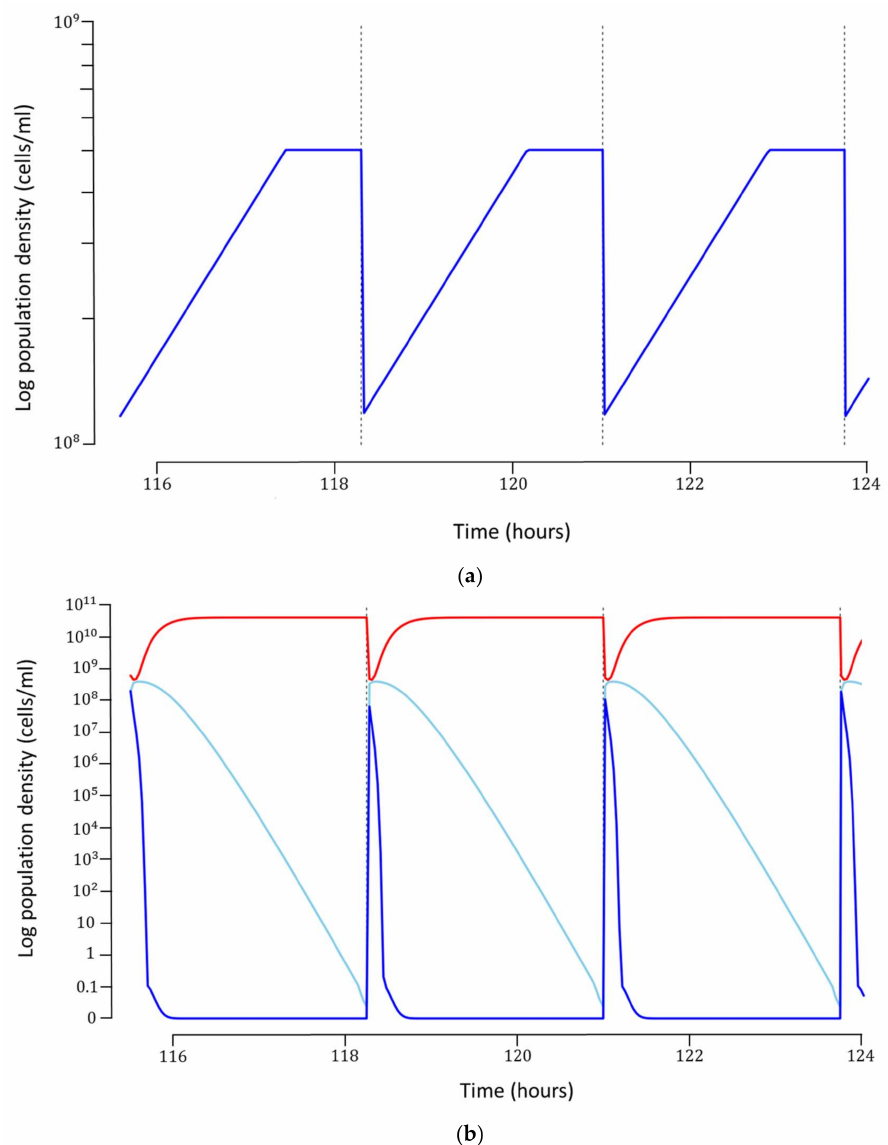
Figure 3. The concentration of bacteria and phages during simulation of the two-stage, self-cycling process for phage production. ( a ) SCF-tank where only susceptible bacteria X S (blue line ) are grown; ( b ) SCI tank where susceptible bacteria X S (blue line ), infected bacteria X I (turquoise line ) and phages P (red line ) are grown. Vertical bars represent cycling events, where phages are harvested from the SCI tank and bacteria are transferred from the SCF to SCI